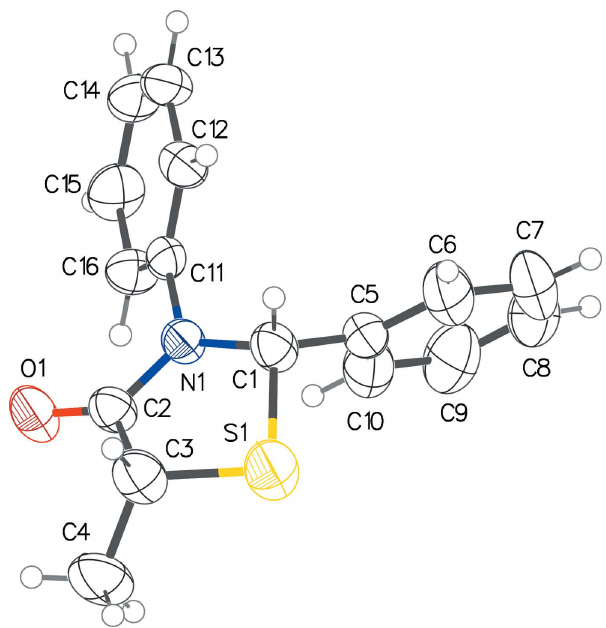
Figure 1 The molecular structure of the title compound, with displacement ellipsoids drawn at the 50% probability